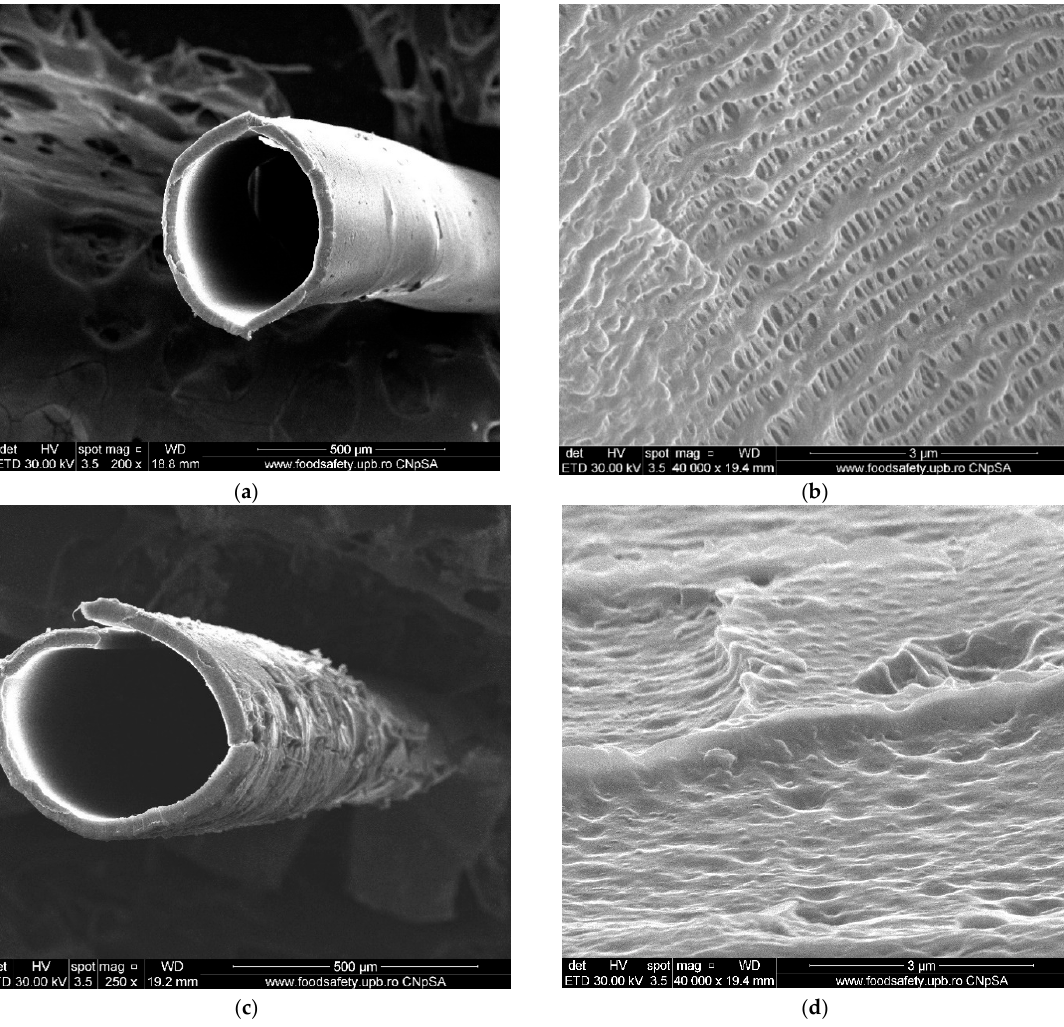
Figure 8. SEM images of the morphological aspect of the membrane support: ( a ) cross-section of the microporous poly- propylene; ( b ) the surface of the microporous polypropylene; ( c ) a cross-section of the polypropylene fiber impregnated with nanoparticles dispersion; and ( d ) surface of the polypropylene impregnated with nanoparticles dispersion. The choice of membrane support and dispersion of magnetic nanoparticles contain- ing iron oxide and silver in n -alcohols as a membrane medium (Figure 9) ensured a de- crease of the membrane thickness that resulted in a reduced diffusion path of the permeate (nitrophenol), an increase of the mass transfer surface per volume unit, as well as a con- vective transport due to the magnetic stirring.